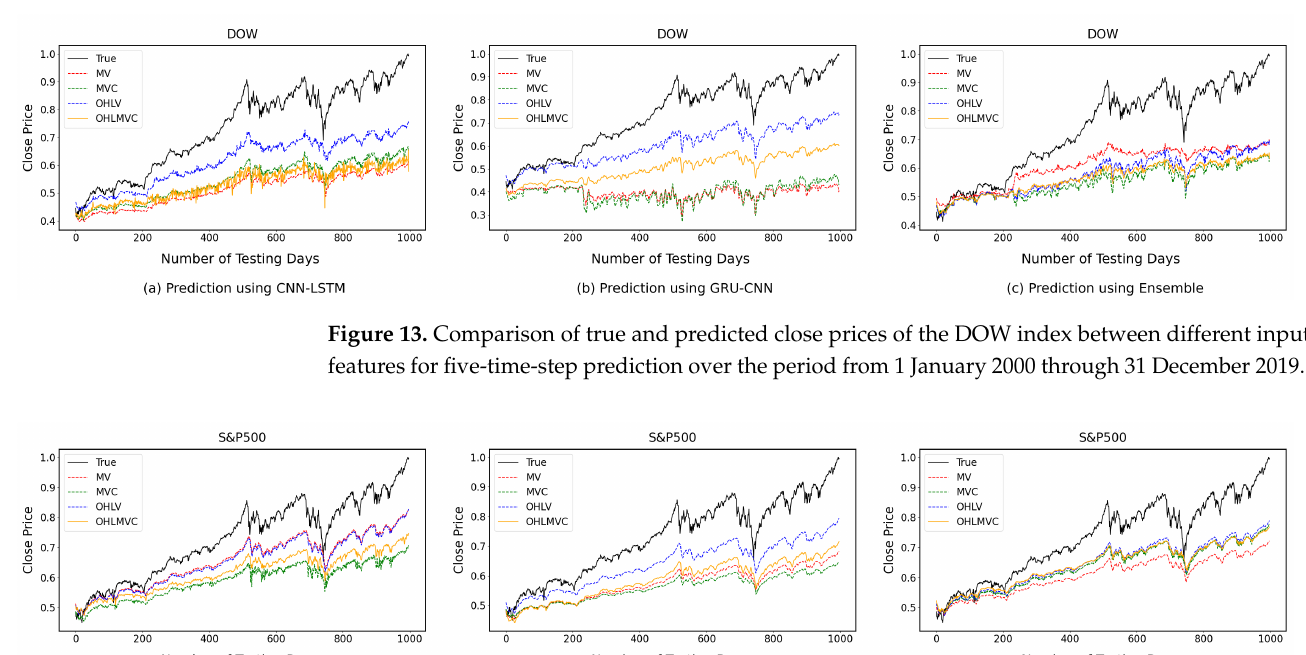
Figure 12. Comparison of true and predicted close prices of the DAX index between different input features for five-time-step prediction over the period from 24 October 2014 through 31 December 2019.